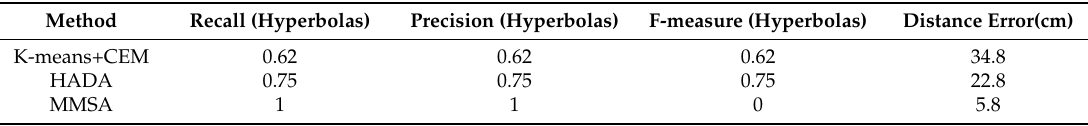
Table 1. Results for data set 1 ( Recall , Precision and F-measure with respect to